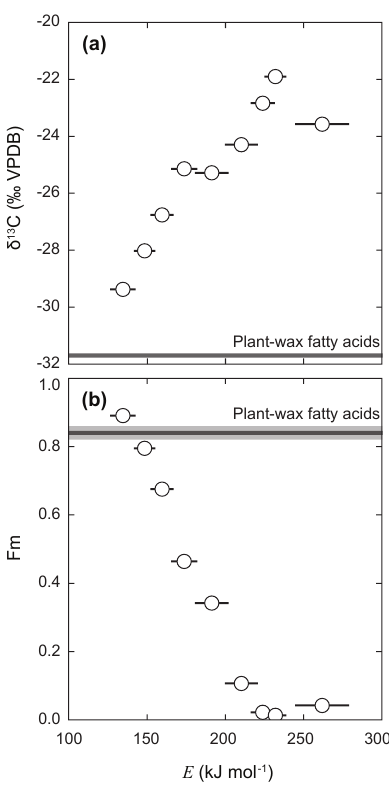
Figure 9. E vs. isotope relationships. (a) E vs. δ 13 C and (b) E vs. Fm for Narayani POC. All isotope values have been corrected for blank carbon contribution following Hemingway et al. (2017), and δ 13 C values have additionally been corrected for kinetic fractiona- tion. Gray lines and shading are the plant-wax fatty acid biomarker isotope values (mean ± 1SD analytical uncertainty; Galy et al., 2011; Galy and Eglinton, 2011). Note that plant-wax fatty acids are known to contain less 13 C (lower δ 13 C values) than corresponding bulk biospheric OC. Each point is plotted at E = E f . Error bars in E are equal to σ f , while δ 13 C and Fm analytical uncertainty is always smaller than point marker and is therefore not